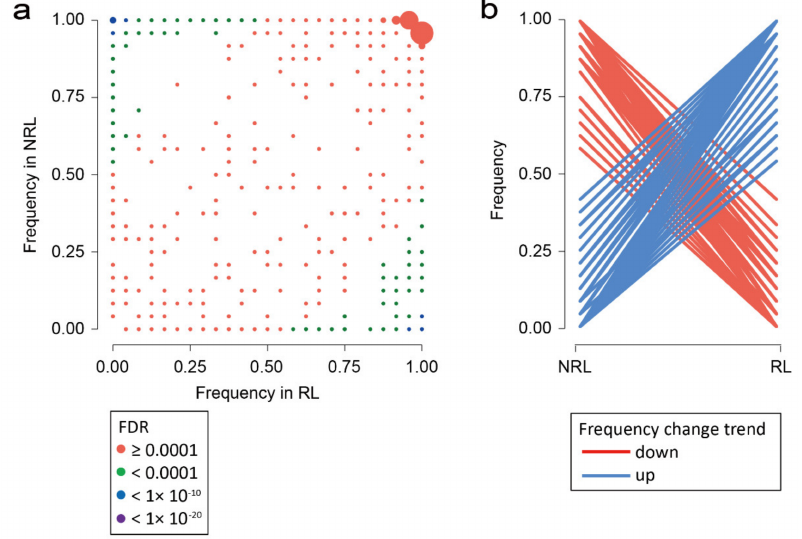
Figure 6. Gene selection preference by rice and non-rice hosts. ( a ) Scatter plots show occurrence frequencies of 1599 genes with PAV in RL and NRL. The different colors of the points represented the different value ranges of FDR, and the size of circle represented the number of genes with the same occurrence frequency. ( b ) Two kinds of occurrence frequency patterns of the putative selected genes by rice and non-rice